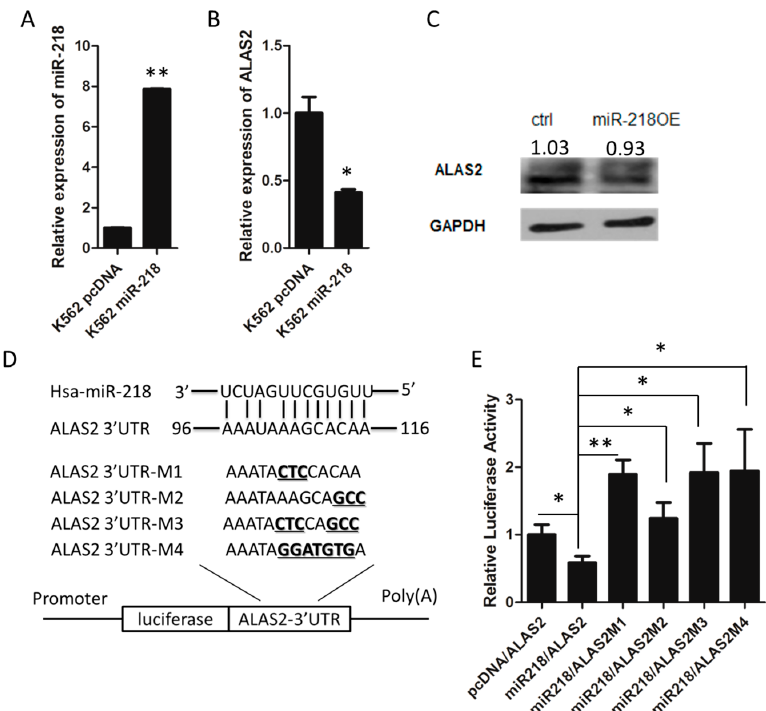
Figure 4. ( A ) The overexpression of miR-218 in K562 cells was confirmed using mature miRNA quantitative real-time PCR normalized to U6 . The expression of ALAS2 at the mRNA level ( B ) and at the protein level ( C ) in K562 control and K562 miR-218 cells was measured by quantitative real-time PCR and western blot, respectively. Western blot quantification normalized to GAPDH by densitometry using ImageJ was provided; ( D ) Predicted binding site for the seed sequence of miR-218 in the 3 ′ UTR of ALAS2 mRNA. Four mutated forms of the 3 ′ UTR were used to generate luciferase reporter constructs as shown. The mutated nucleic acid was shown in bold and underlines; ( E ) miR-218 inhibits wild-type, but not the mutated ALAS2 3 ′ UTR. Asterisks indicate that differences between samples were statistically significant according to an independent-sample t -test, * p < 0.05, ** p < 0.01.